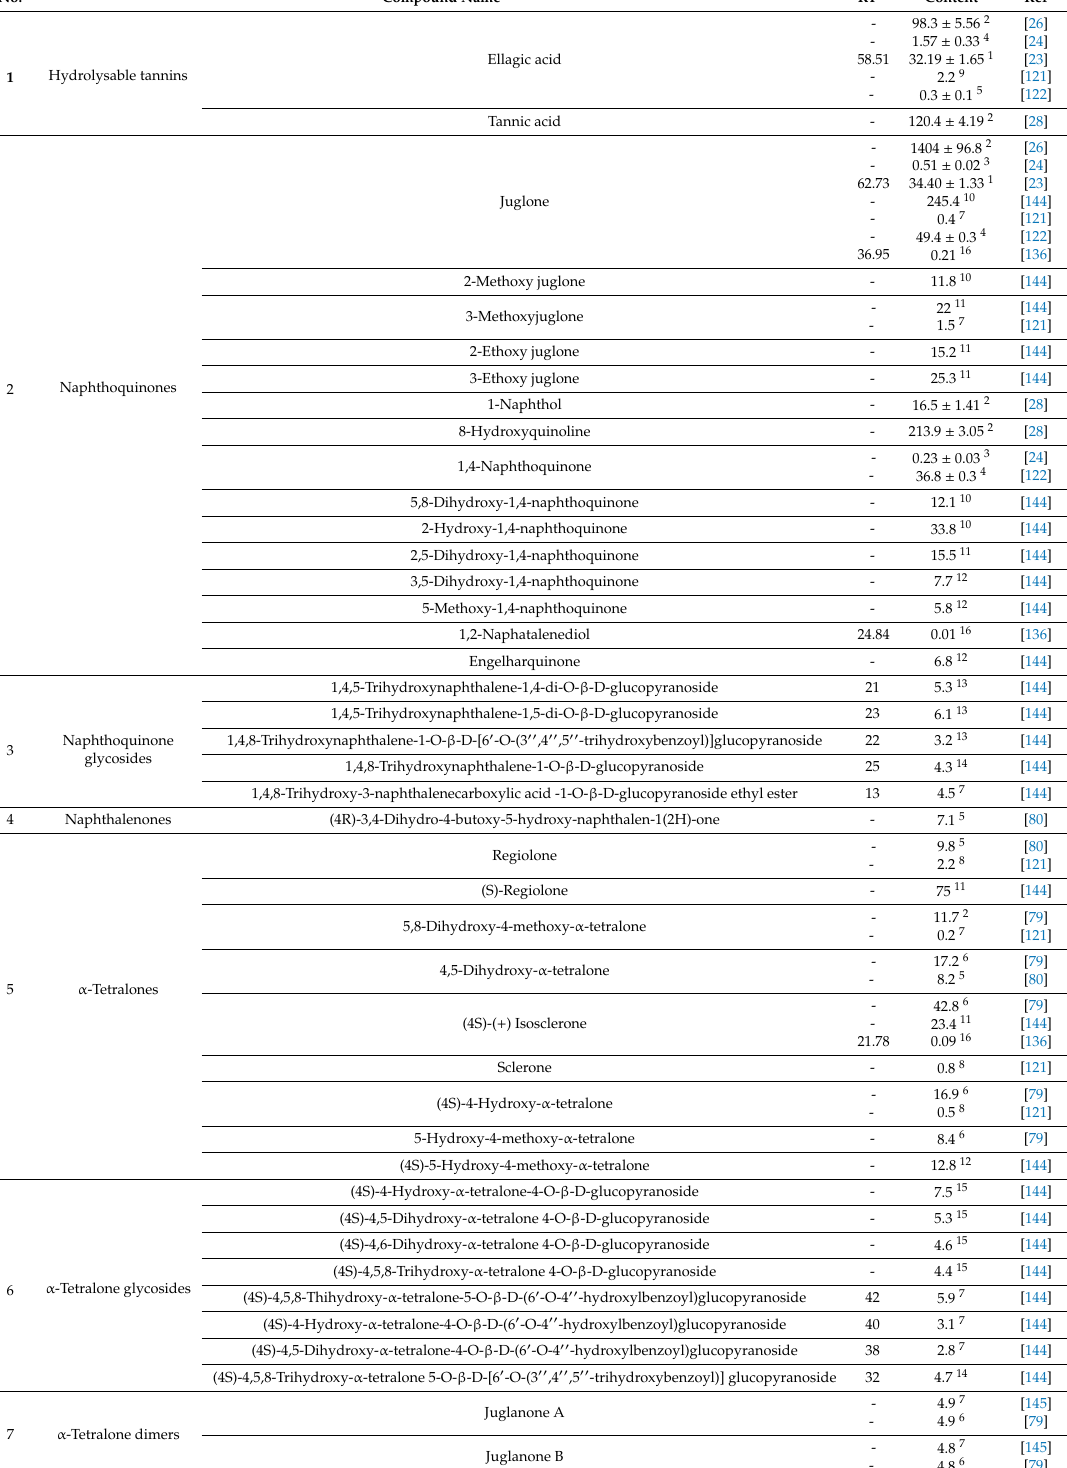
Table 2. Di ff erent identified hydrolysable tannins and naphtoquinones, naphthalenones, α -tetralones, and α -tetralone dimers, as well as their glycoside derivatives in the green walnut husk along with their retention time and